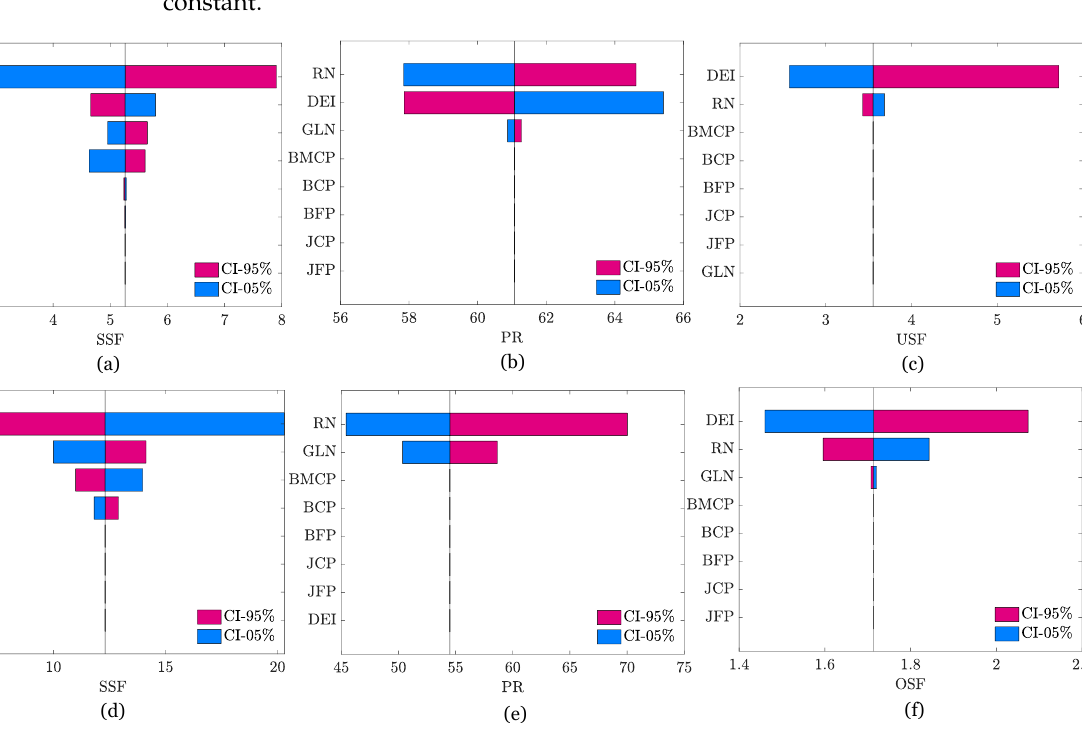
Figure 4. TD: ( a ) Base joint—sliding safety factor (SSF), ( b ) Base joint—position of the resulting force (PR), ( c ) Base joint—uplift safety factor (USF), ( d ) Crest joint—SSF, ( e ) Crest joint—PR, and ( f ) Base joint—overturning safety factor